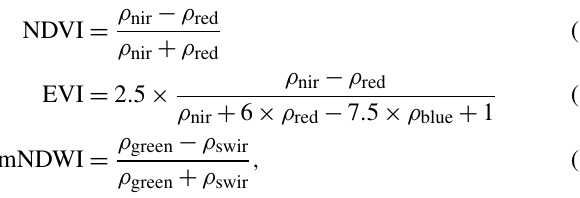
identify those pixels with terrain shadows (Zou et al.,